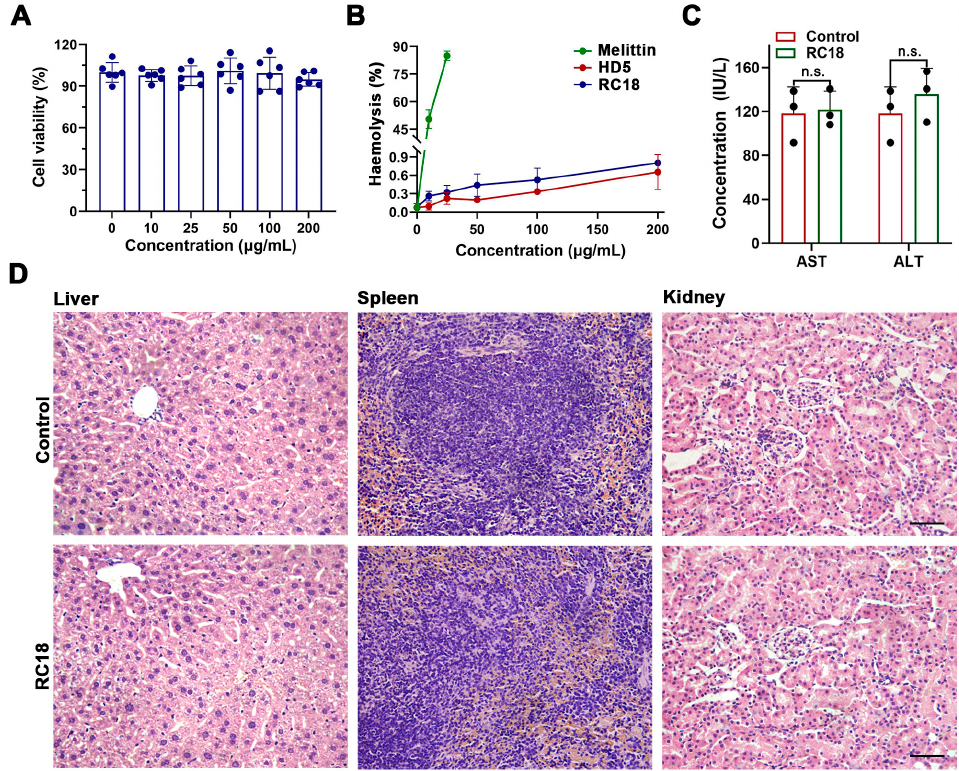
Figure 5. ( A ) Survival of HUVECs exposed to RC18 at various concentrations. Dots indicate indi- vidual results from three independent experiments. ( B ) Haemolysis of the peptides with melittin applied as a positive control. The results are presented as the mean ± SD. ( C ) Levels of AST and ALT in the plasma of mice in the presence or absence of RC18 treatment. Dots indicate individual results from three mice. n.s., not significant. ( D ) HE staining of the liver, spleen, and kidney of RC18-treated mice. Mice in the control group were treated with PBS. The scale indicates 200 μ m .